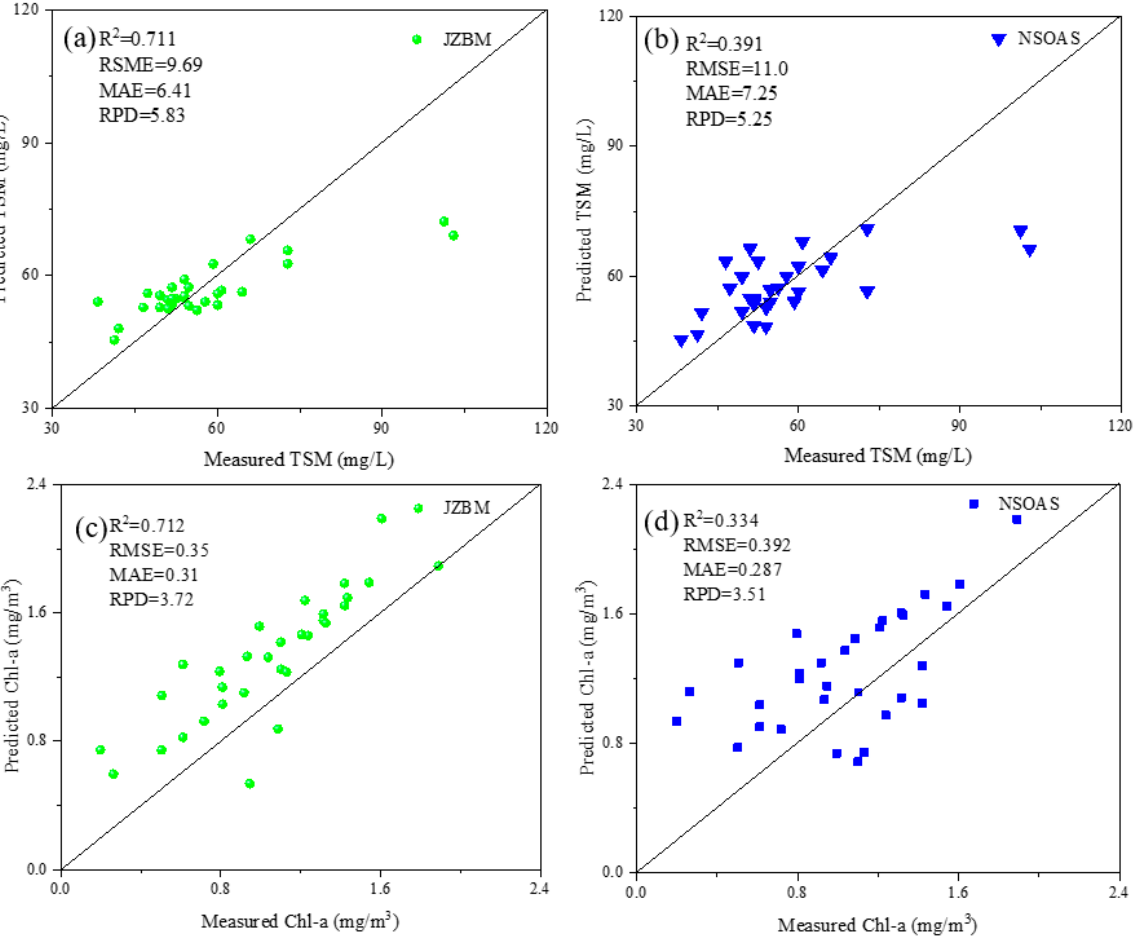
Figure 5. Comparison of the estimated and measured values of the TSM concentration by JZBN model ( a ) and NSOAS model ( b ), and the Chl-a concentration by JZBN model ( c ) and NSOAS model ( d ).